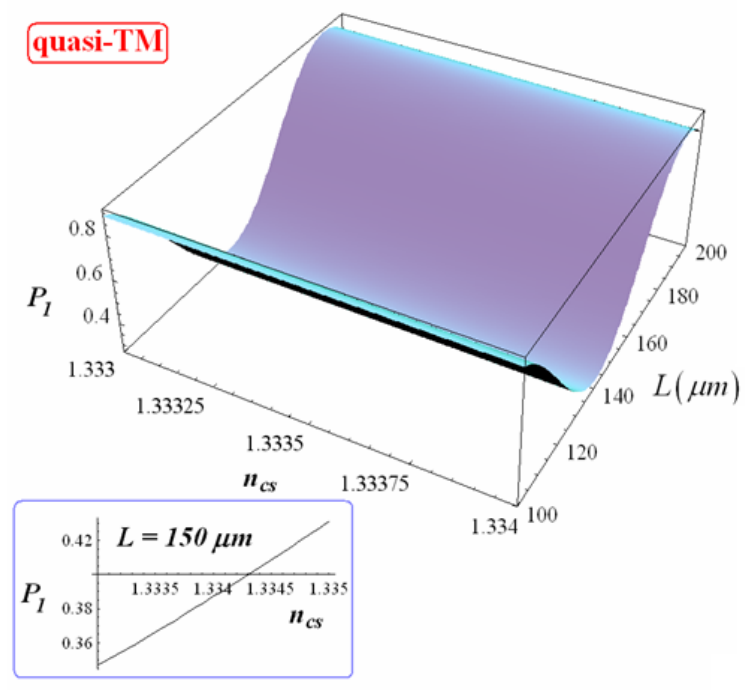
on n is shown, with L = 150 μ 1 cs